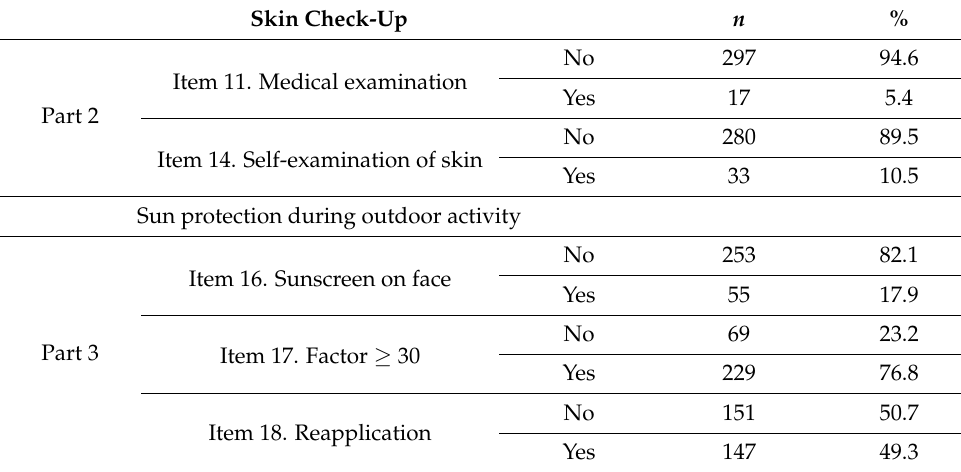
Table 3. Skin check-up and sun protection during outdoor